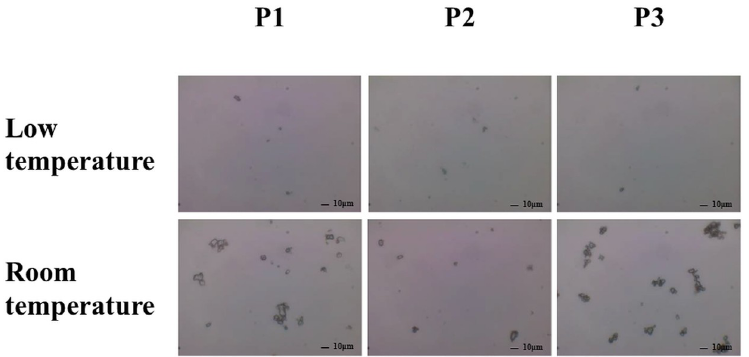
Fig 4. Influence of storage temperature on the dispersibility of 0.1% FLU ophthalmic suspensions. In the low (upper panels) and room (lower panels) temperature groups, each formulation of 0.1% FLU ophthalmic suspension was stored at 10 ˚C for three months and subsequently maintained at room temperature for two months or left at room temperature for five months. Optical microscopic images of the dispersible particles of FLU ophthalmic suspension at 100x magnifications are shown. P1; Original, P2; Generic A, P3; Generic B. All the images are representative of three independent experiments.